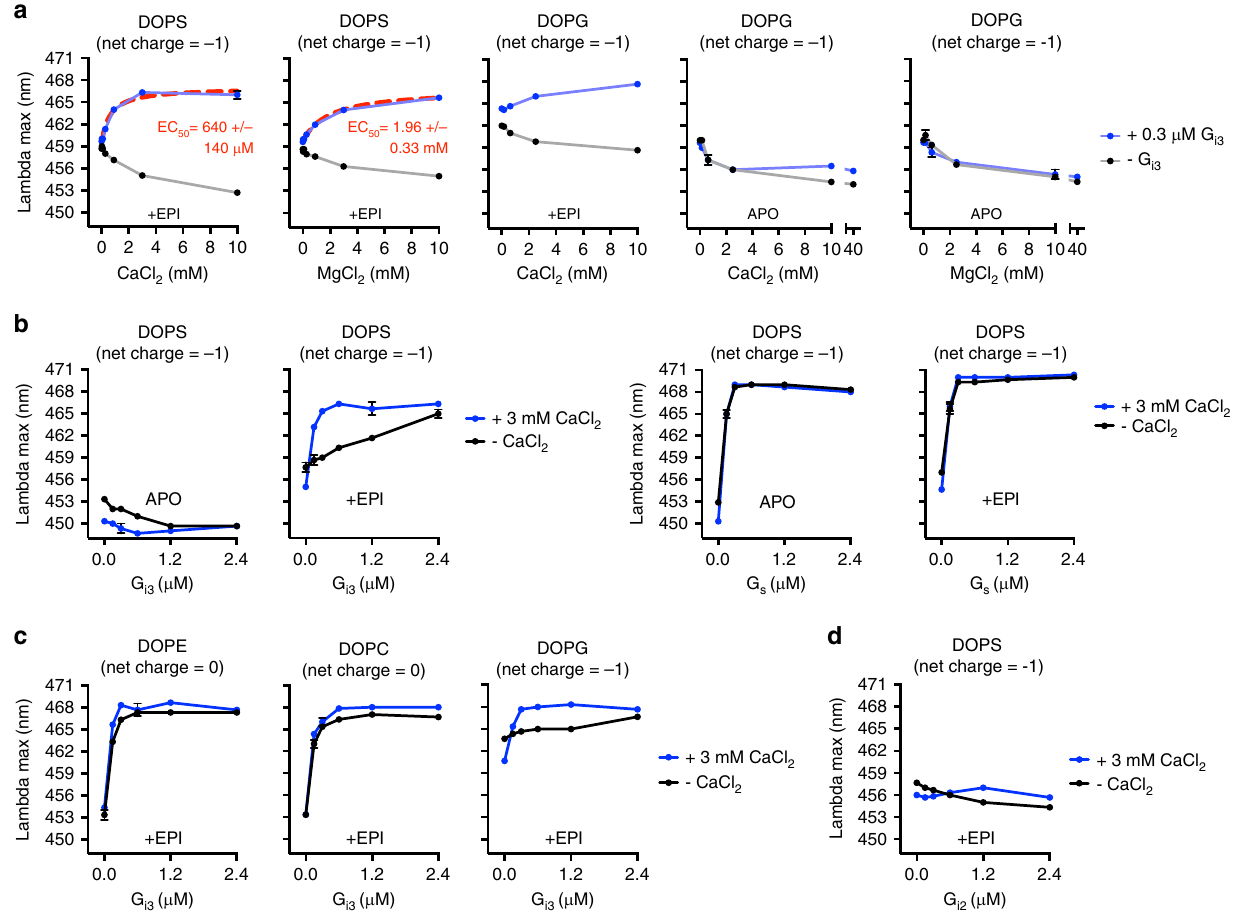
Fig. 5 Ca 2 + and Mg 2 + facilitate G i3 coupling in negatively charged bilayers a The effect of CaCl 2 and MgCl 2 concentration on mB − β 2 AR fl uorescence in DOPS and DOPG nanodisc bilayers was examined in the presence and absence of G i3 . Epinephrine was included (30 μ M) or omitted (APO). EC 50 is mean ± s.e.m. b The effect of G protein concentration (G i3 and G s ) on mB − β 2 AR fl uorescence ± 3 mM CaCl 2 was examined in DOPS nanodiscs in the absence (APO) and in the presence (EPI) of epinephrine (30 μ M). c The effect of G i3 on mB − β 2 AR fl uorescence ± 3 mM CaCl 2 was examined in DOPE, DOPC,